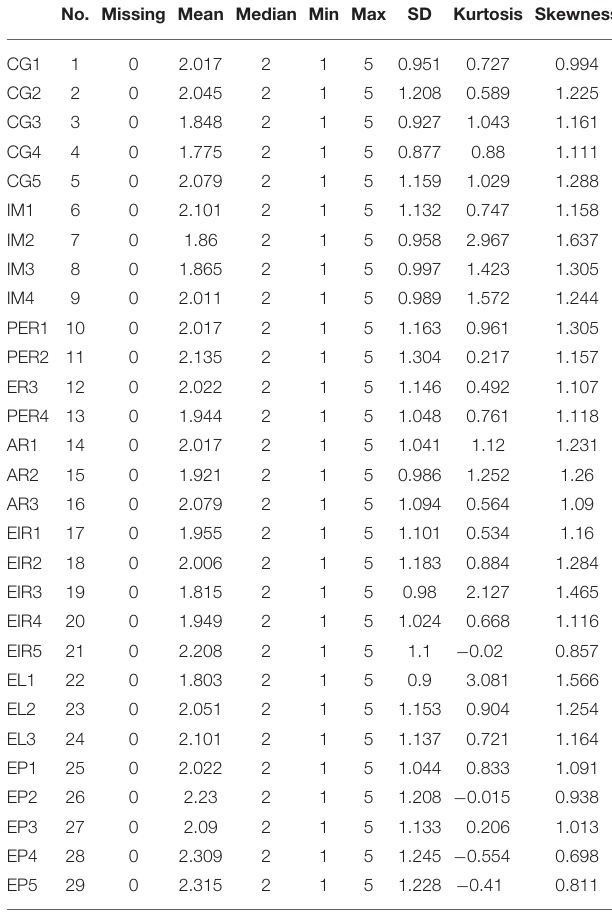
No. Missing Mean Median Min Max SD Kurtosis